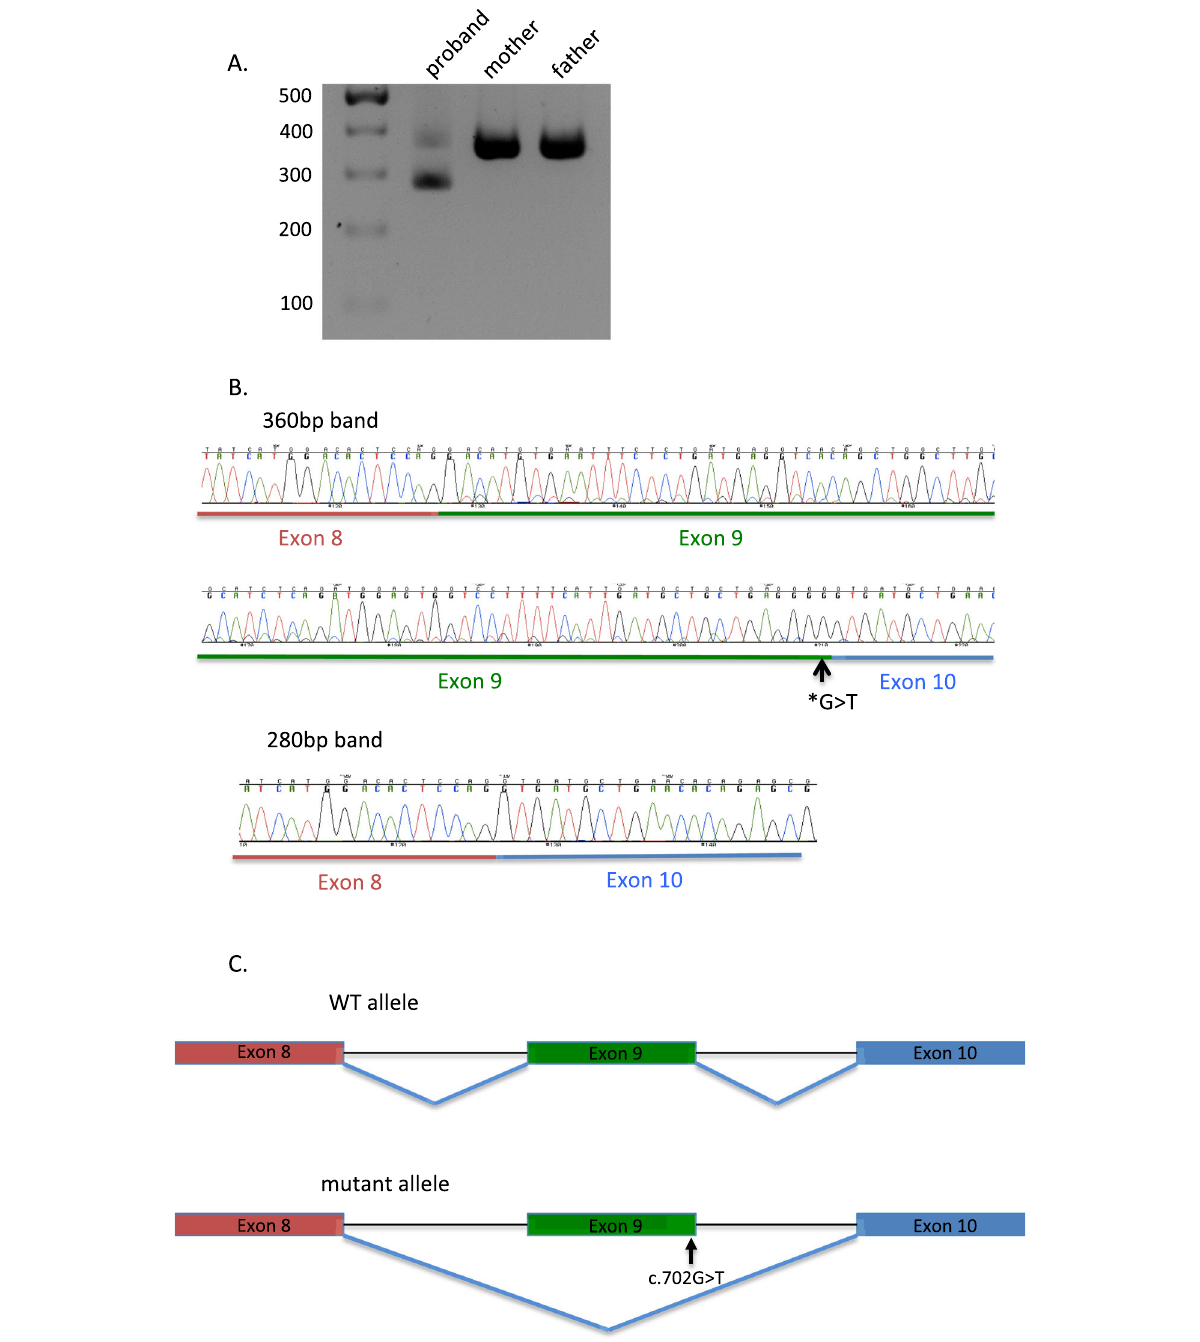
Fig. 3 NM_004247.4 ( EFTUD2 ): c.702G > T variant induces exon skipping. a Electrophoresis gel of EFTUD2 cDNA obtained after amplification of the variant region from the proband and its parents. The proband displays two bands, one at 360 bp and one at 280 bp. b Electropherogram from Sanger sequencing 360 bp and 280 bp bands from the electrophoresis gel in A. The exon 8 is highlighted in red, the exon 9 in green and the exon 10 in blue. The exon 9 – exon 10 junction of EFTUD2 cDNA shows exon 9 skipping in cDNA of 280 bp band which is presented only in the proband. c Schematic representation of the exon 9 skipping in the mutant allele of the proband compared to the wild type (WT)